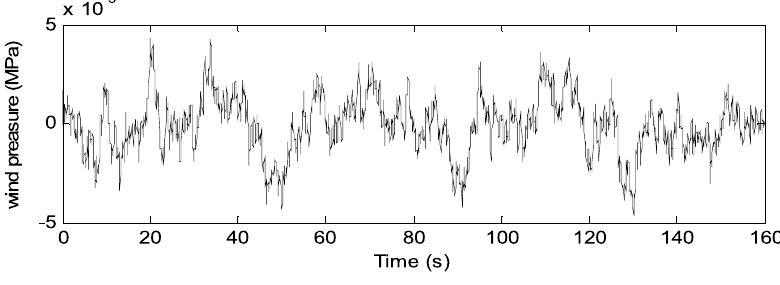
Fig. 3. Pressure time history of fl uctuating wind.